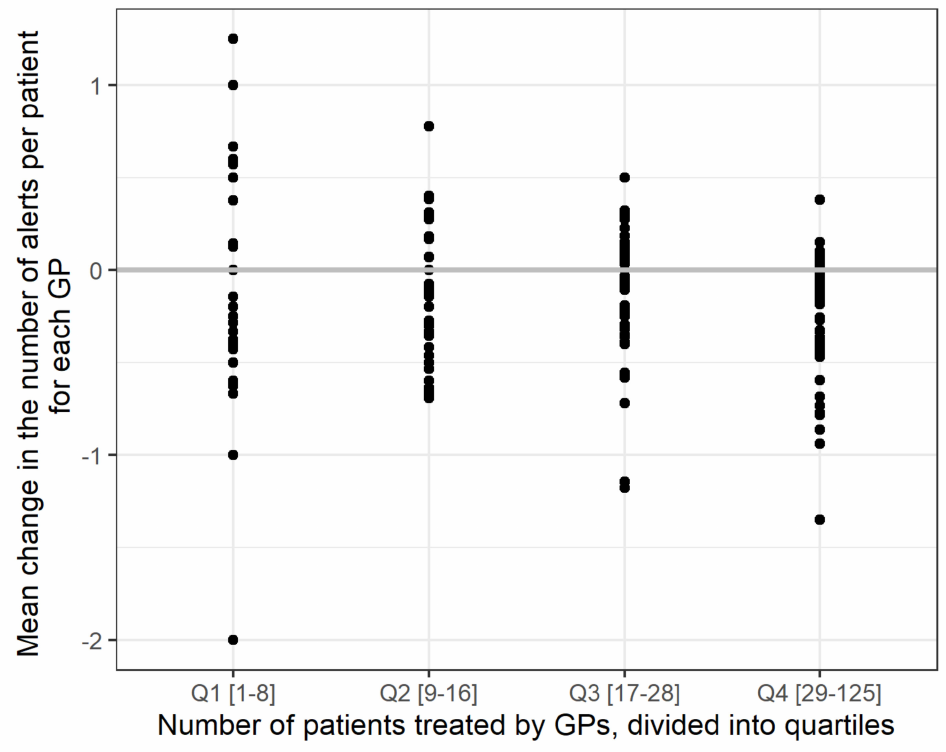
Figure 4. Average change in the number of alerts per GP, stratified according to the number of patients from the active study population treated by the GP (expressed in quartiles).